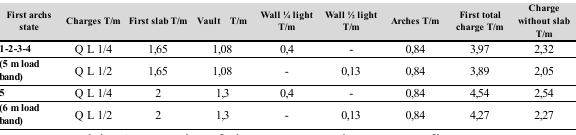
Table 1. Loads of the structural system: first